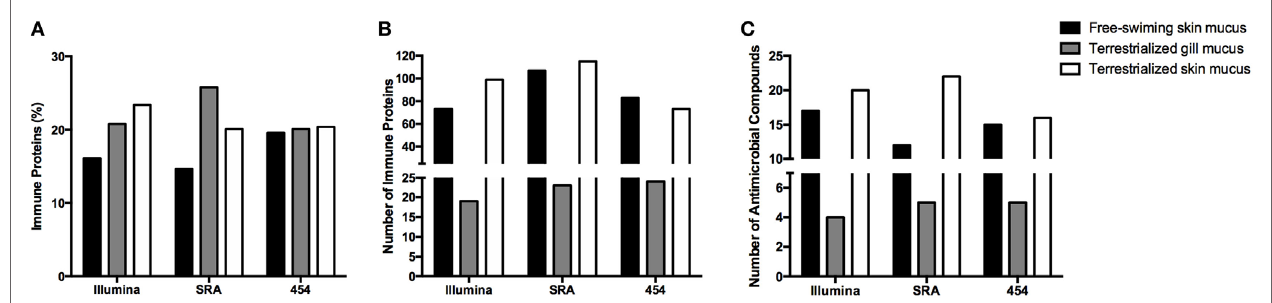
FigUre 5 | (a) Percentage of proteins and (b) total number of proteins with known immunological function in the three mucus samples obtained in this study using the Illumina transcriptome, the sequence read archive (SRA) transcriptome, or the 454 transcriptome databases. (c) Total number of proteins with known antimicrobial function in the skin identified in the three mucus samples using the Illumina transcriptome, SRA transcriptome, or the 454 transcriptome